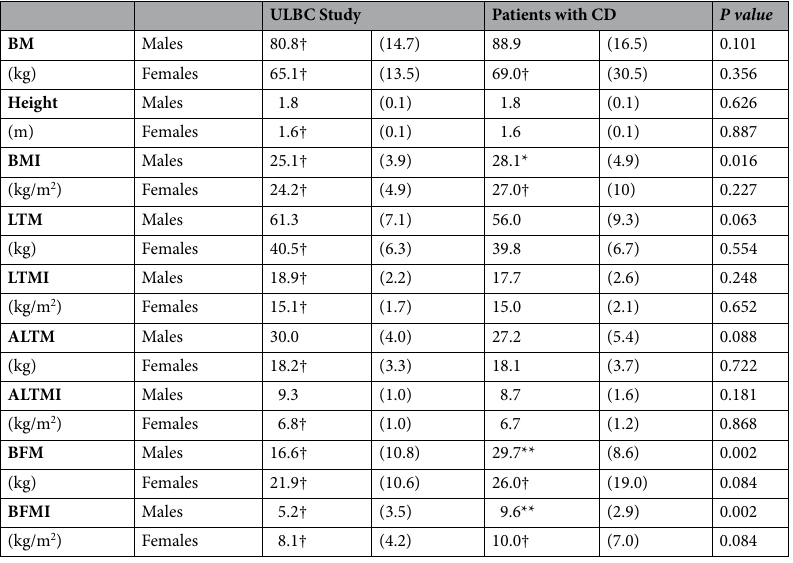
Table 2. Body compositional measurements of participants compared with ULBC. ULBC, University of Limerick Body Composition; CD, Crohn’s disease; BM, body mass; BMI, body mass index; LTM, lean tissue mass; LTMI, lean tissue mass index; ALTM, appendicular lean tissue mass; ALTMI, appendicular lean tissue mass; BFM, body fat mass; BFMI, body fat mass index. * p < 0.05 ** p < 0.005 † not normally distributed (CD patients: Shapiro Wilk, p < 0.05; ULBC: Kolmogorov–Smirnov, p < 0.05). Data are presented as mean (SD) or median (IQR). CD subjects: n = 30, males n = 13, females n = 17. Age 20–73y. ULBC: n = 1606, males n = 683, females n = 923.